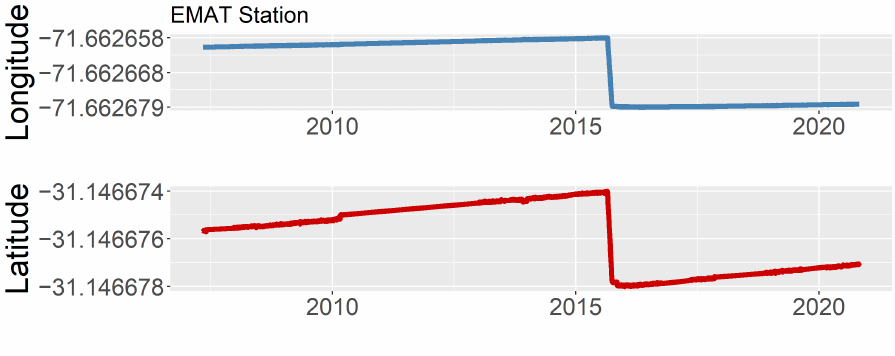
Figure 7. Time series of the GPS measurements in the EMAT station: longitude ( top ) and latitude ( bottom